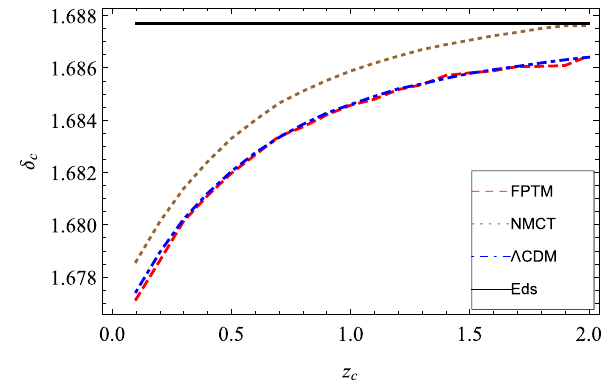
Fig. 15 The behaviour of the linear overdensity parameter δ c versus z c for the Λ CDM , FPTM, NMCT and Eds models